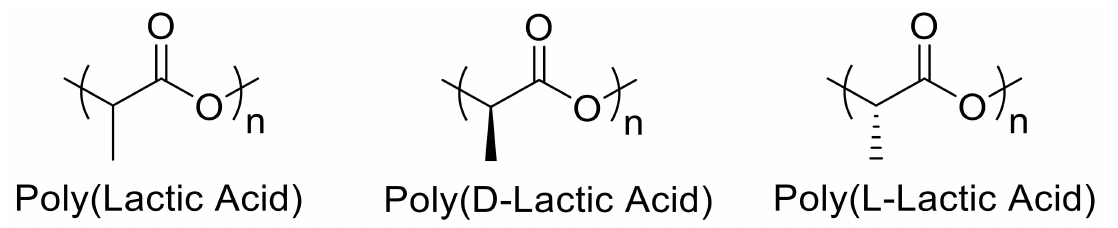
Figure 1. Poly(lactic acid)